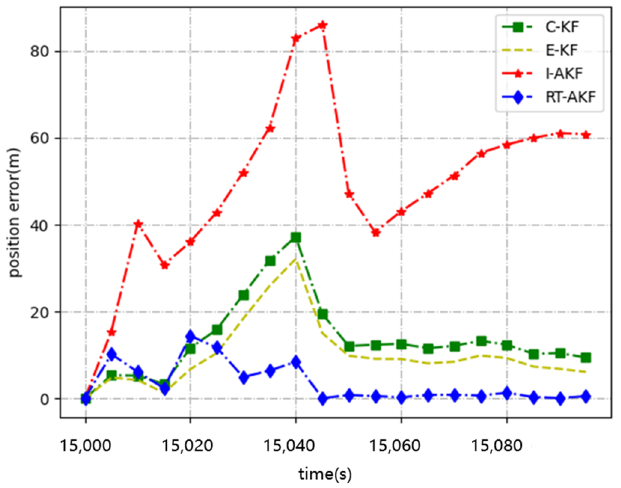
Figure 10. The positioning errors of GNSS/INS tightly coupled integrated by different methods in